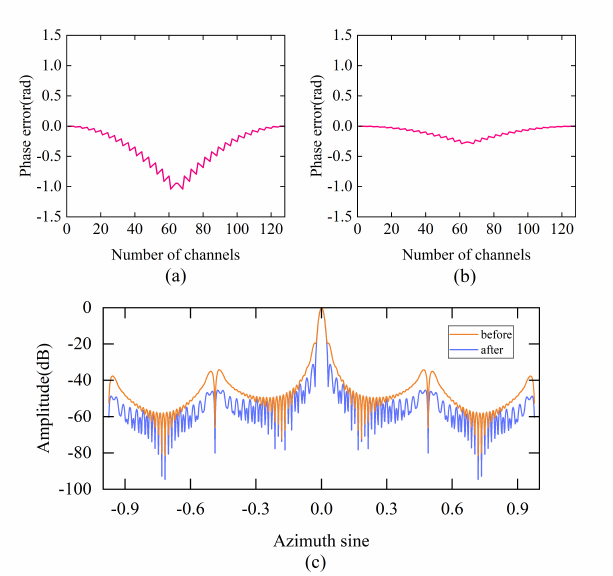
Figure 8. ( 20 m,0 ◦ ) Target compensation result. ( a ) Phase error before compensation. ( b ) Phase error after compensation. ( c ) Azimuthal profile.